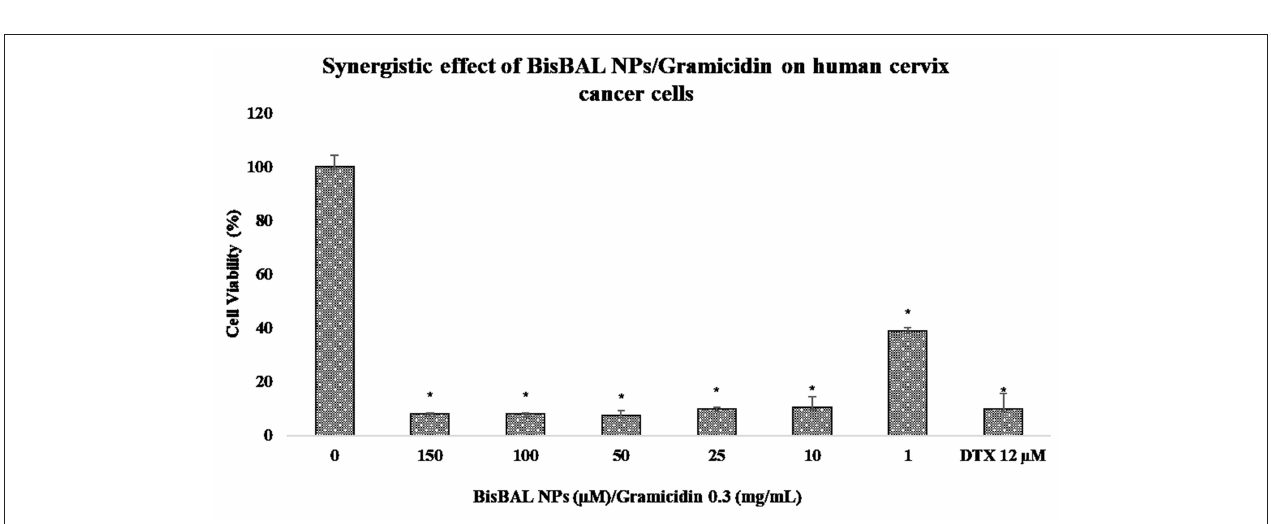
FIGURE 6 | Synergistic effect of gramicidin and bismuth lipophilic nanoparticles on HeLa cells. A monolayer of HeLa cells was exposed to 0.3 mg/mL gramicidin win combination with varying concentration of BisBAL NPs. Negative control, pure culture medium; positive control, 12 µ M of docetaxel (DTX). Synergistic activity was significant ( p < 0.0001) in all combinations. Asterisks indicate statistical difference ( α =